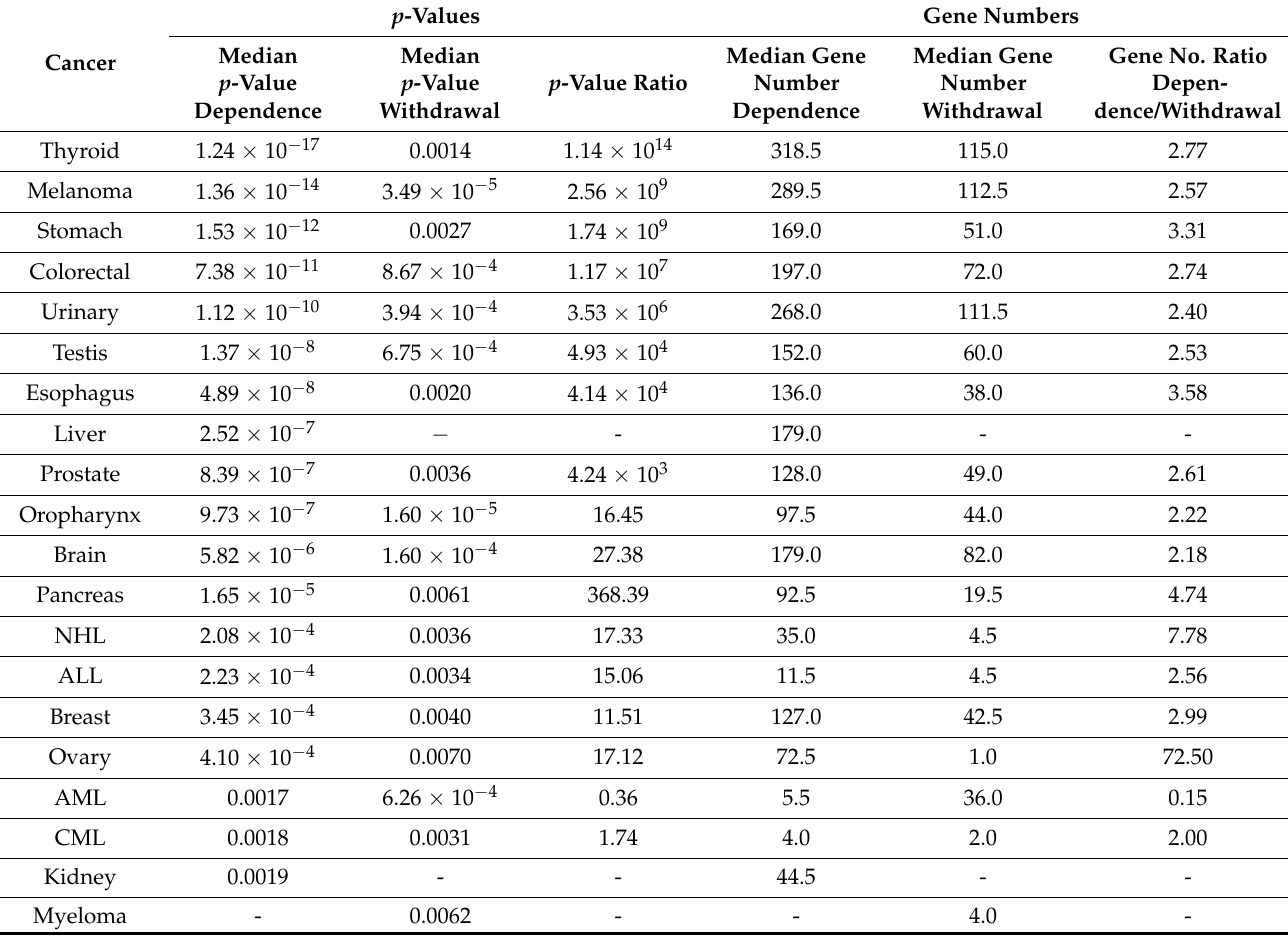
Table key: This Table considers the experimental conditions of cannabis dependence and cannabis withdrawal separately. Cancers were grouped by cancer type. The table lists the various classes of gene numbers and p -values and their ratios as described in the column headings. All data is taken from results reported from the epigenomic data appendix in the study of Schrott and colleagues as referenced